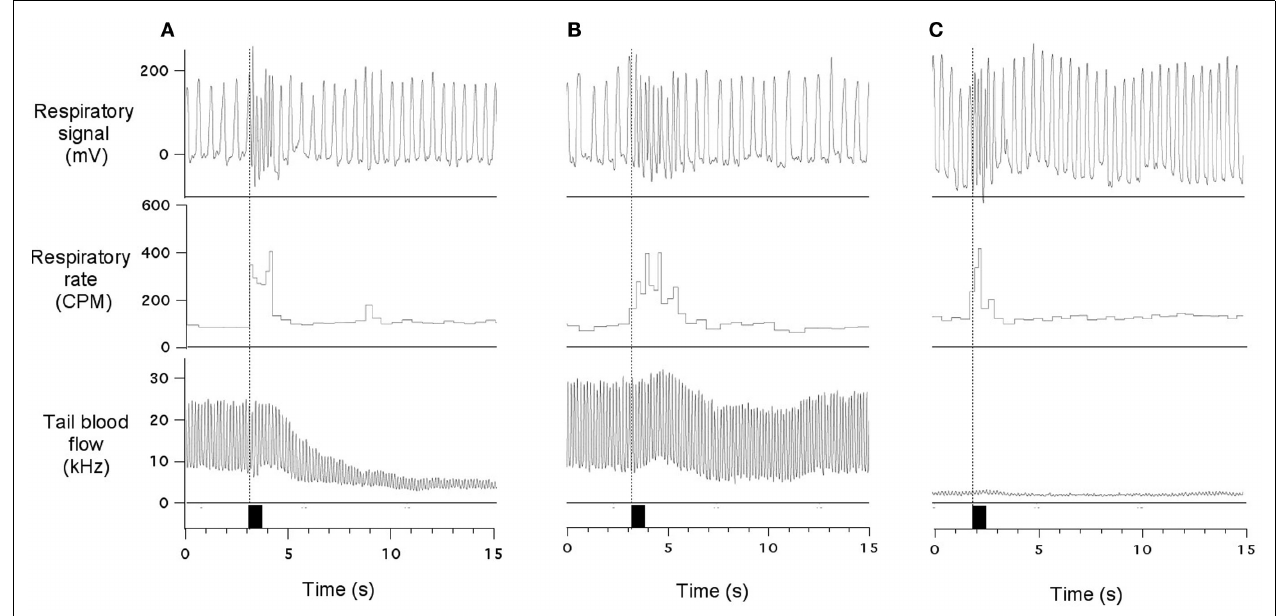
FIGURE 3 | Sudden acoustic stimuli provoke increases in respiratory rate associated with variable effects on the cutaneous blood flow. In (A) , stimulus provoked vigorous vasoconstriction in the cutaneous vascular bed; in (B) - very modest cutaneous effect was observed; and in (C) - cutaneous